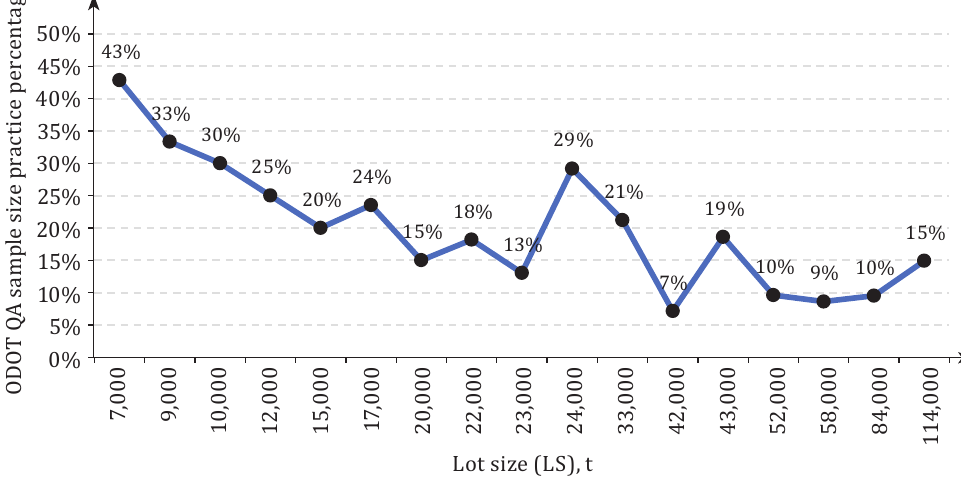
Figure 1. ODOT QA n performed practice percentage for AC and